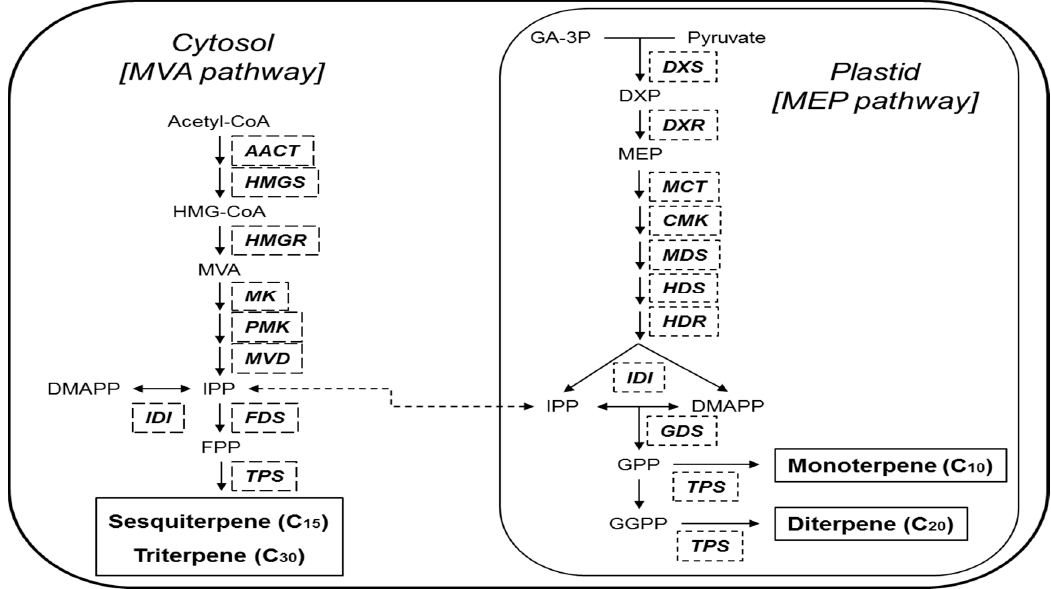
Figure 1. Volatile terpenoid biosynthetic pathways in plants. AACT , Acetoacetyl-CoA thiolase; CMK , 4-(cytidine 5 ′ -diphosphate)-2- C -methyl- D -erythritol kinase; DMAPP , dimethylallyl diphosphate; DXP, 1-deoxy- D -xylulose 5-phosphate; DXR , DXP reductoisomerase; DXS , DXP synthase; FDS , farnesyl diphosphate synthase; FPP, farnesyl diphosphate; GA-3P, glyceraldehyde-3-phosphate; GDS , geranyl diphosphate synthase; GGPP, geranylgeranyl diphosphate; GPP, geranyl diphosphate; HDR , (E) -4-hydroxy-3-methylbut 2-enyl diphosphate reductase; HDS , (E)- 4-hydroxy-3-methylbut-2-enyl diphosphate synthase; HMG-CoA, 3-hydroxy-3-methylglutaryl-CoA; HMGR , HMG-CoA reductase; HMGS , HMG-CoA synthase; IDI , isopentenyl diphosphate isomerase; IPP, isopentenyl diphosphate; MCT , 2- C -methyl- D -erythritol 4-phosphate cytidylyltransferase; MDS , 2- C -methyl- D -erythritol 2,4-cyclodiphosphate synthase; MEP, 2- C -methyl-D-erythritol 4-phosphate; MK , mevalonate kinase; MVA, mevalonate; MVD , mevalonate diphosphate decarboxylase; PMK , phosphomevalonate kinase; TPS , terpene synthases.